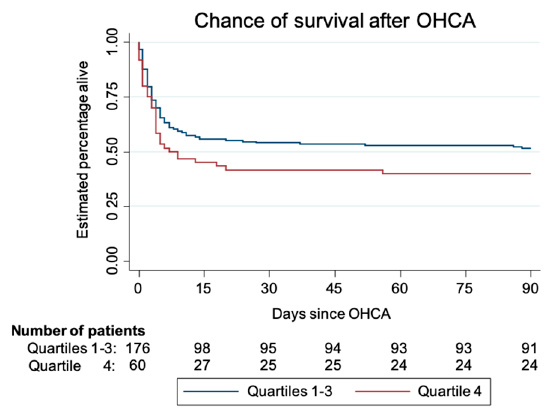
Figure 1. Kaplan–Meier survival.